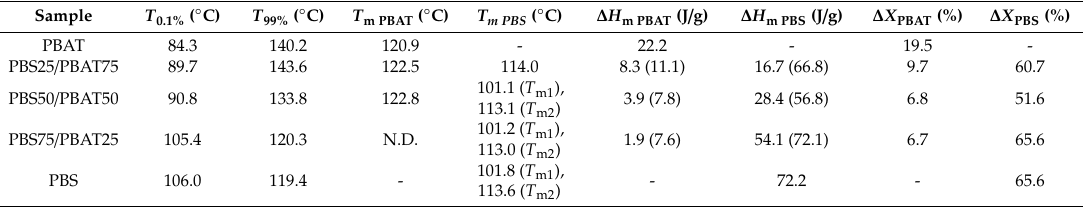
Table 2. DSC results for PBS, PBAT and their blend during the second heating. The values of melting enthalpy in parentheses are normalized with respect to the weight fraction of the polymer in the